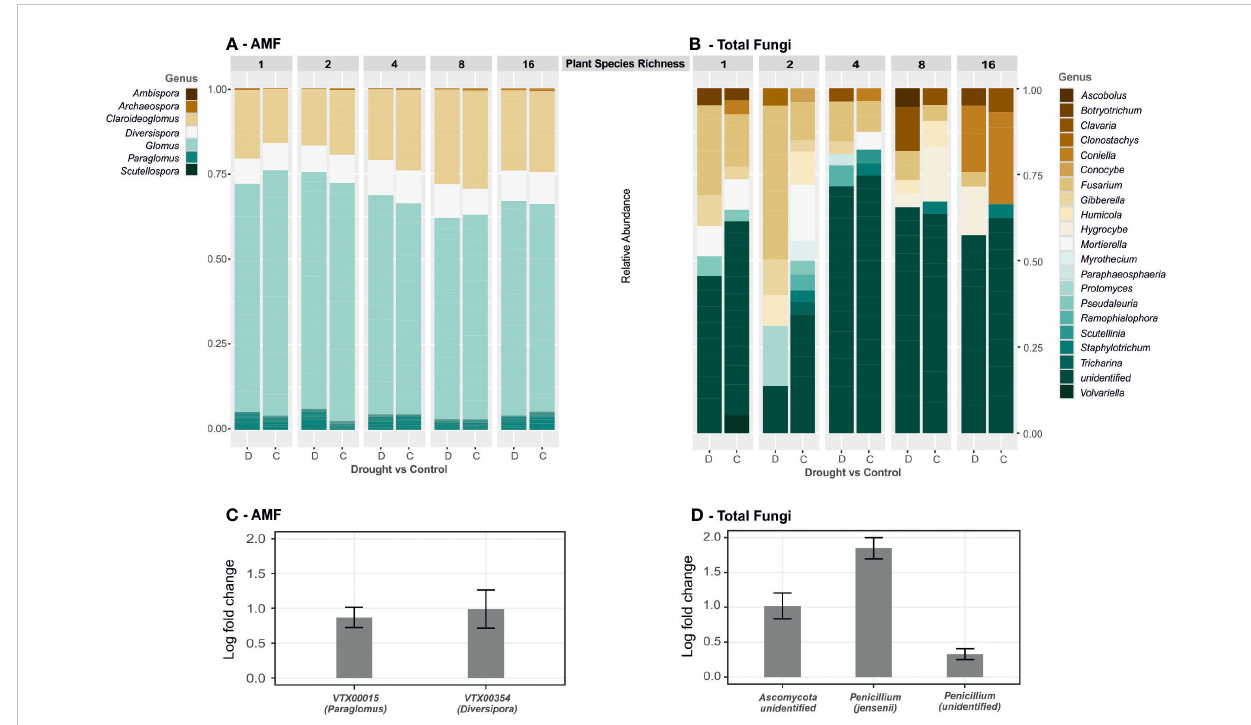
FIGURE 2 Genus level composition and changes of AMF and total fungal communities. Relative abundances of (A) VT of AMF and (B) ASV of total fungal communities > 5%, subdivided by the plant species richness levels (1 to 16) in drought (D) vs control (C) plots. Changes in signi fi cantly differential abundant taxa ( C – AMF, D – total fungi), presented as log fold change of abundance after drought compared to control plots with standard deviations